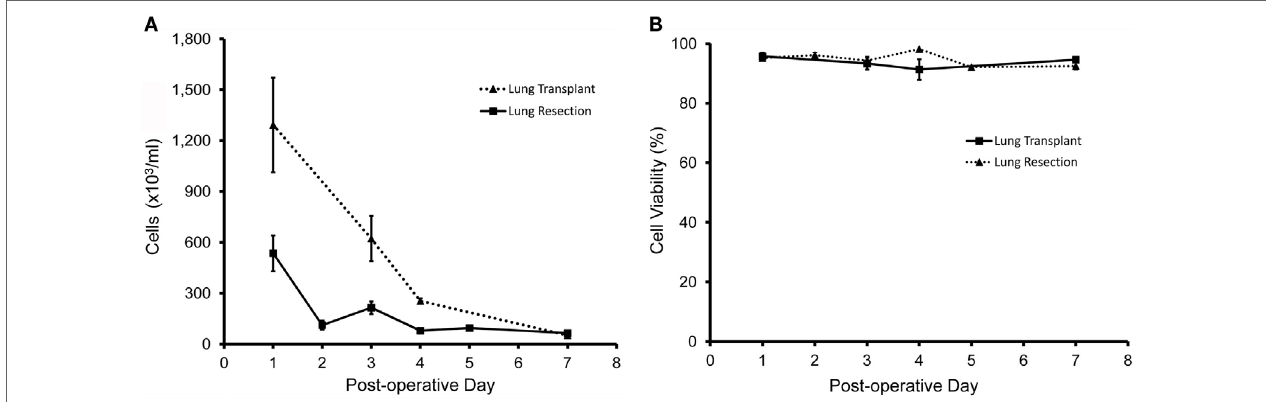
FigUre 1 | Cellular content of pleural fluid after lung resection (solid line) and lung transplantation (dotted line). When clinically available, samples were obtained from N = 45 patients; N = 37 patients after lung resection; and N = 8 patients after lung transplantation. (a) After red cell lysis, cell concentrations were determined by manual counting with a hematocytometer. (B) Cell viability was determined by light microscopy and trypan blue exclusion (27) as well as stage scan fluorescent microscopy after calcein-AM and ethidium homodimer-1 cell viability staining. Error bars reflect ± 1